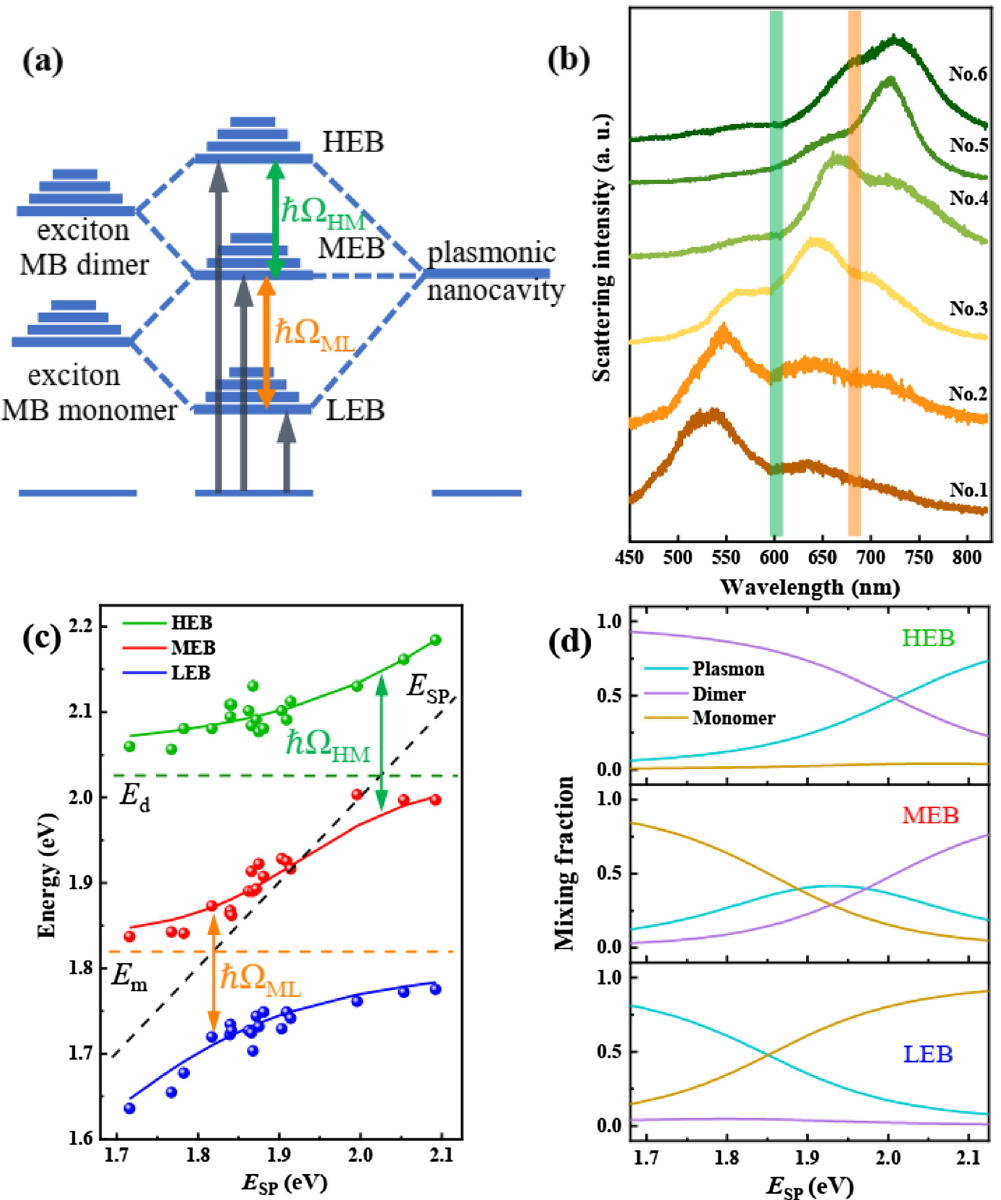
Figure 4: Strong monomer exciton-plasmon-dimer exciton coupling. (a) Schematic representation of the strong coupling between the excitons of the monomeric and dimeric dye molecule (left) and the surface plasmons of nanocavity (right), leading to the formation of three new eigen hybrid light – matter states: HEB, MEB and LEB. The Rabi splitting energies are marked as ℏ Ω HM and ℏ Ω ML , respectively. (b) Scattering spectra of the hybrid nanostructures with different Ag nanocube sizes (sample numbers from No. 1 to No. 6). SPR wavelength of the plasmonic nanocavity is tailored across the exciton resonances of dimer and monomer MB. (c) Dispersion of plexciton with HEB, MEB and LEB varied as a function of plasmon energy. Green, red and blue dots